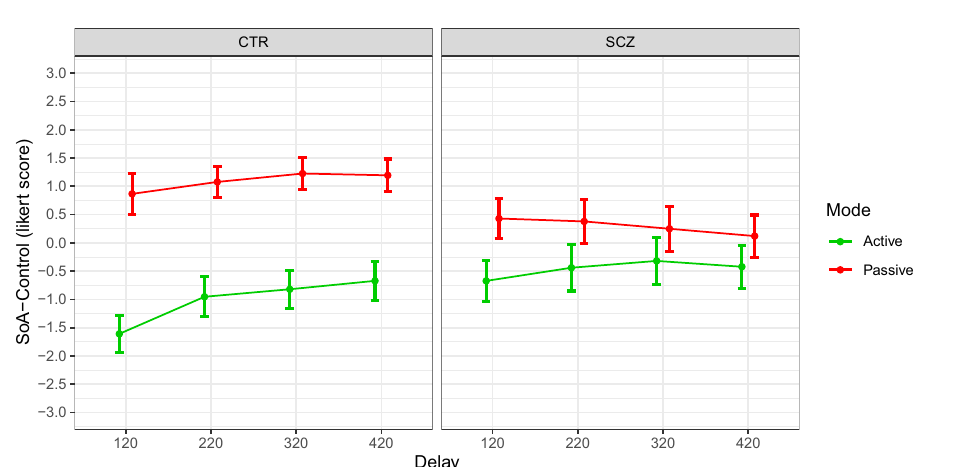
Figure 2. SoA-Control scores. The graph illustrates mean questionnaire ratings by group and experimental condition. Green and red lines represent active and passive conditions respectively. Error bars = 95% confidence